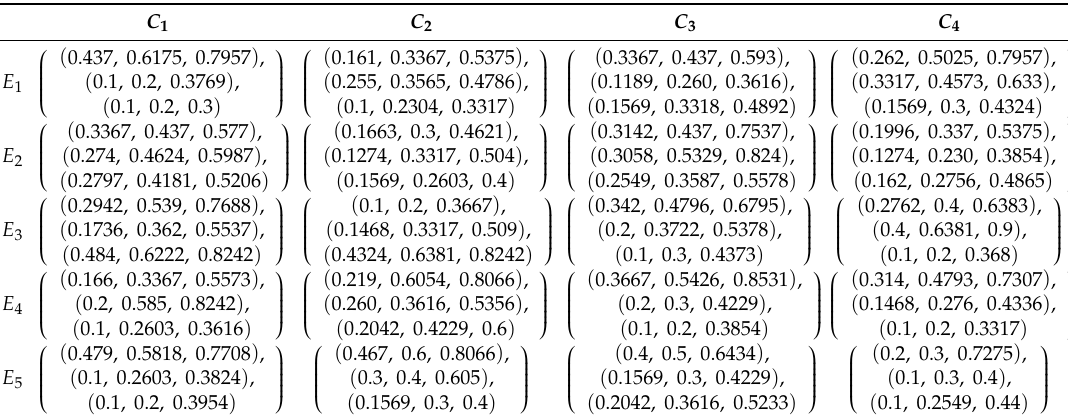
Table 4. The group TFNNs decision matrix F by TFNNWA